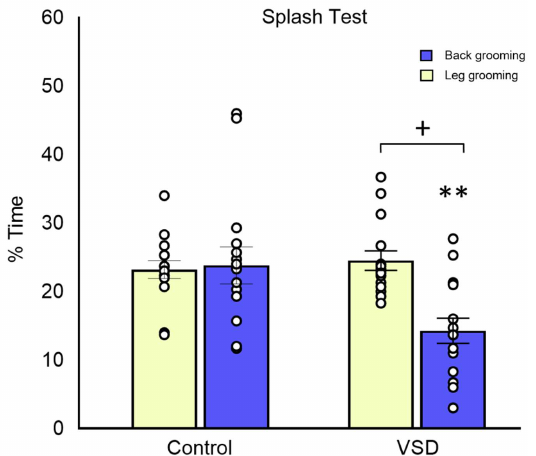
Figure 6. Vicarious Social Defeat (VSD) in female mice increases anhedonia in the splash test (ST). The bars depict the percentage of time in leg and back grooming in the ST (Control n = 15; VSD n = 15). Stress effect in total grooming [F(1,30) = 5.805; p< 0.023], + p< 0.05 significant differences with respect to controls. Stress effect in back grooming [F(1,28) = 8.269; p< 0.008], ** p< 0.01 significant differences with respect to controls.